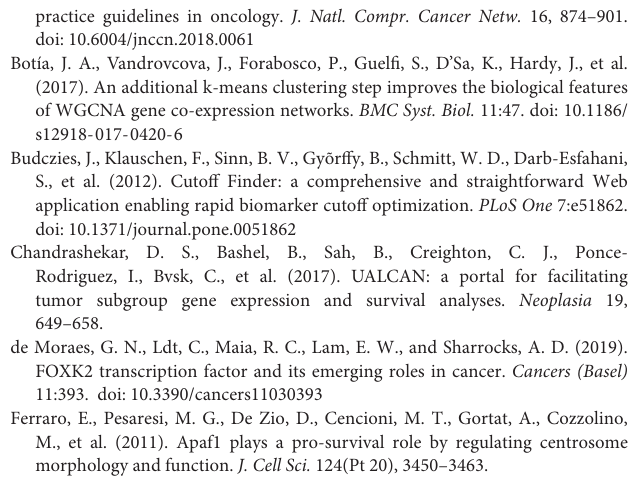
P = 0.246). (C) Person analysis between the AJCC TRG grade and FTSJ3 expression. ROC curves and AUC statistics to evaluate the predictive efficiency of the FTSJ3 in our data and external data to distinguish CRT-resistance from CRT − sensitive CRC cases from (D) our data and (E) GSE35452. The disease-free survival (F) and overall survival (G) between low and high expression of FTSJ3. Supplementary Figure 2 | The result of Cut-off Finder. Plot of the OR of the UTP6 (A) and FTSJ3 (D) expression and the optimal cutoff value. And the optimal cutoff value is compared to the gene expression. ROC curves and AUC analysis to evaluate the predictive efficiency of the optimal cutoff of the UTP6 (B) and FTSJ3 (E) expression. The classification using UTP6 (C) and FTSJ3 (F) expression and patients’ DFS status. And the optimal cutoff value is compared to the gene expression. OR, odds ratio; DFS, disease-free